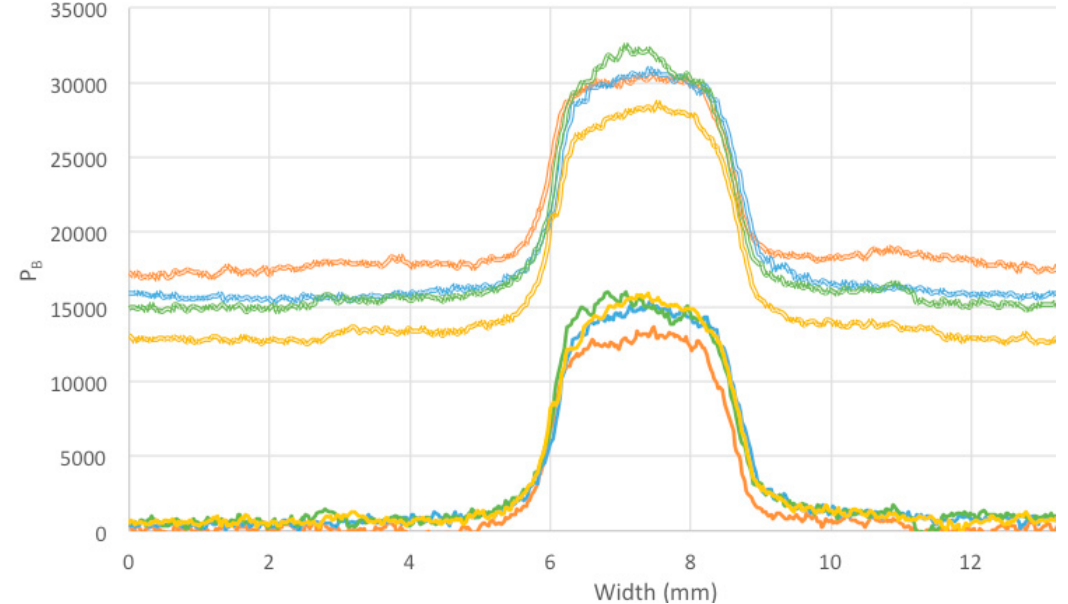
Figure 16. Linear pixel profile scans through the irradiated areas of image 15 (right) without, upper, and with, lower, baseline subtraction. The colour code is orange, B1; blue, B2; yellow, B3; green, B4. The total dose for all beams was 15.9 ± 0.3 Gy with dose rates 3.9, 2.7, 2.0, 1.3 Gy/min for B1, B2, B3, B4.